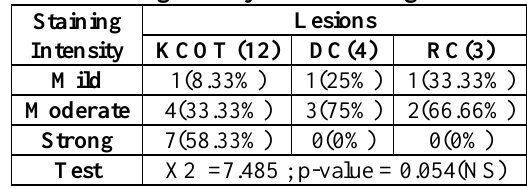
Table 4: Case Distribution of Odontogenic Cysts According to Staining Intensity of Cyclin